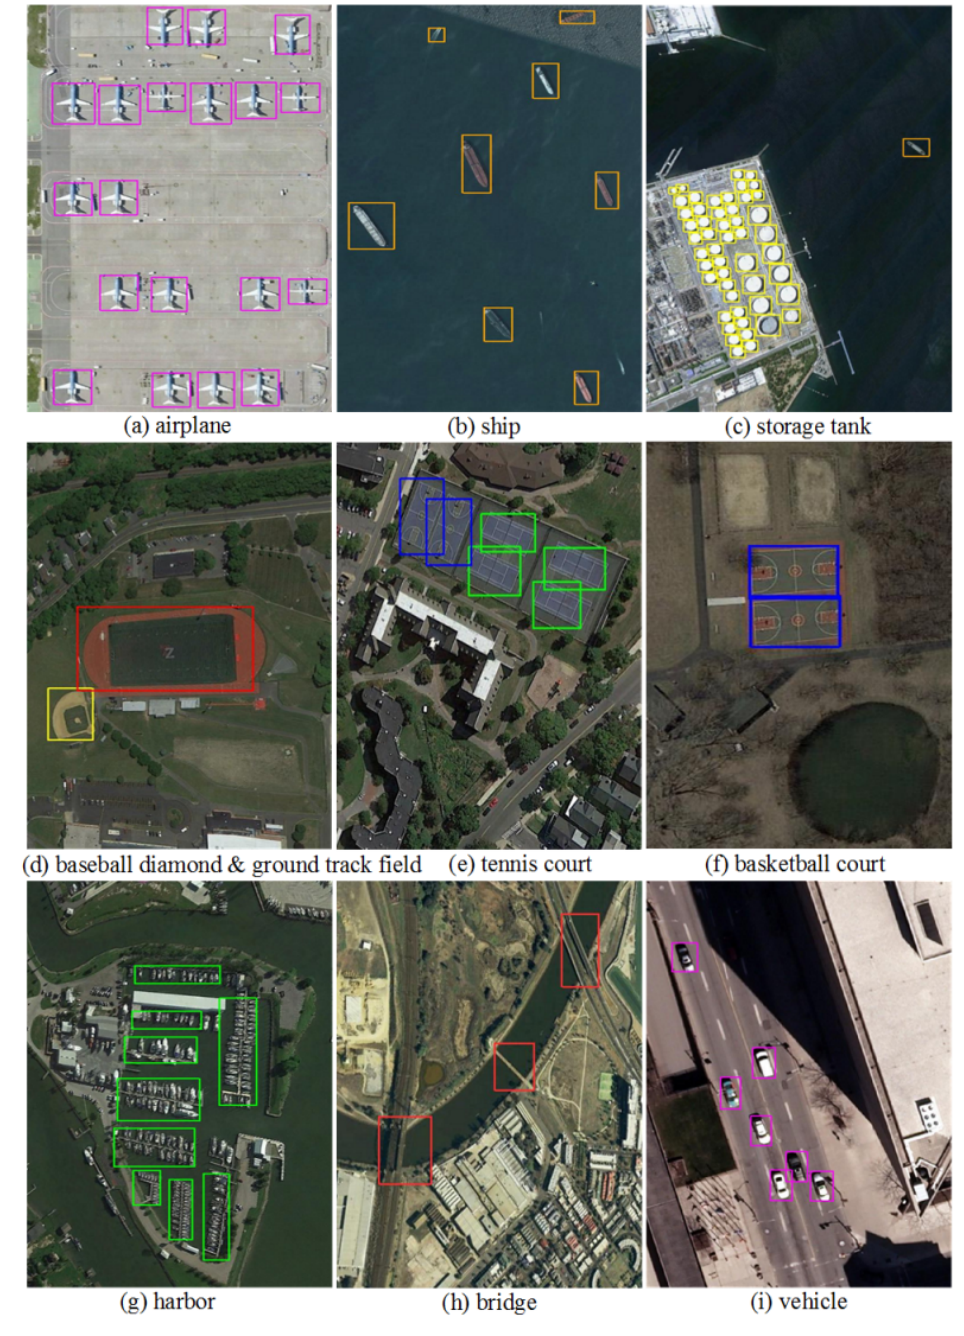
Figure 12. Some instances of detection results obtained by NEOON in 10